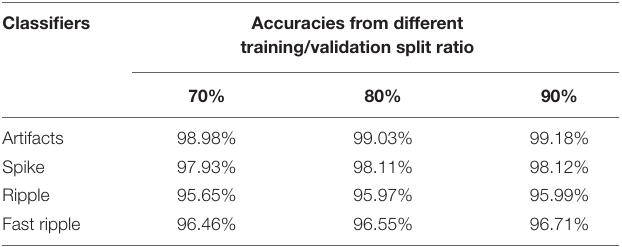
TABLE 1 | Training results of different split ratios for ResNet101